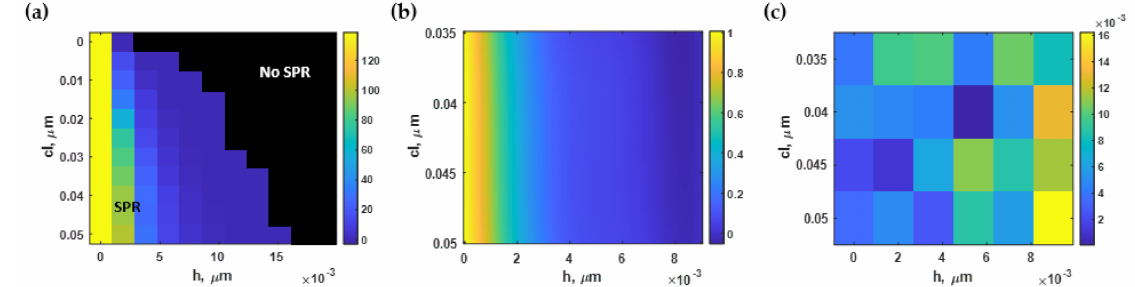
Figure 16. ( a ) The FOM using Monte Carlo simulation; ( b ) the normalized FOM based on Equation (12); and ( c ) the difference between Equation (12) and the RCWA